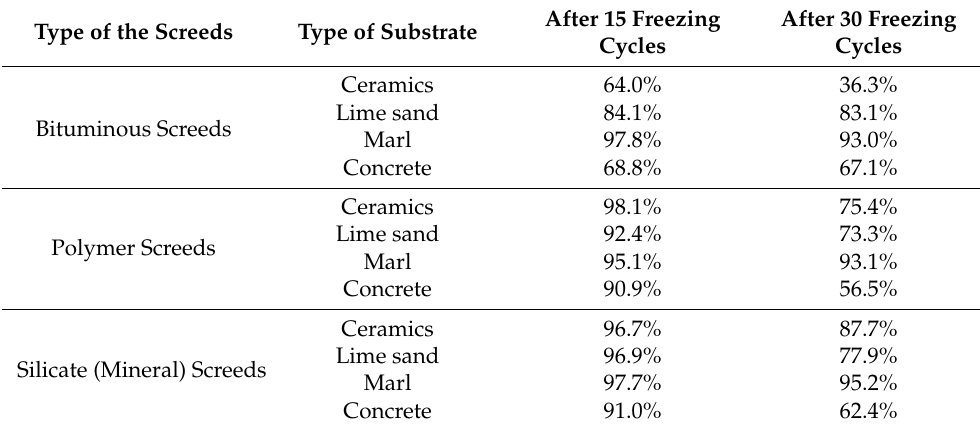
Table 3. Residual strength in